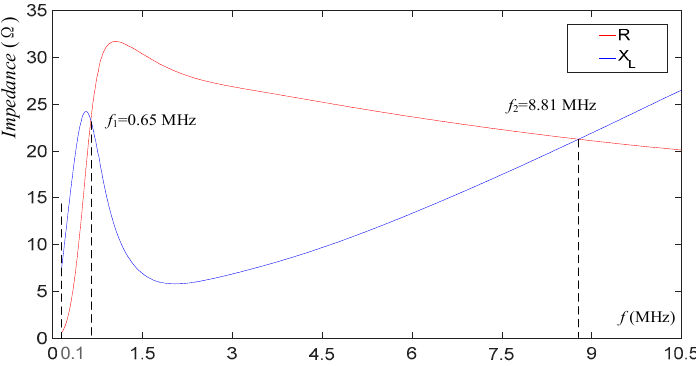
Figure 11. Impedance frequency characteristic of the ferrite ring used for parasitic oscillations dampening.